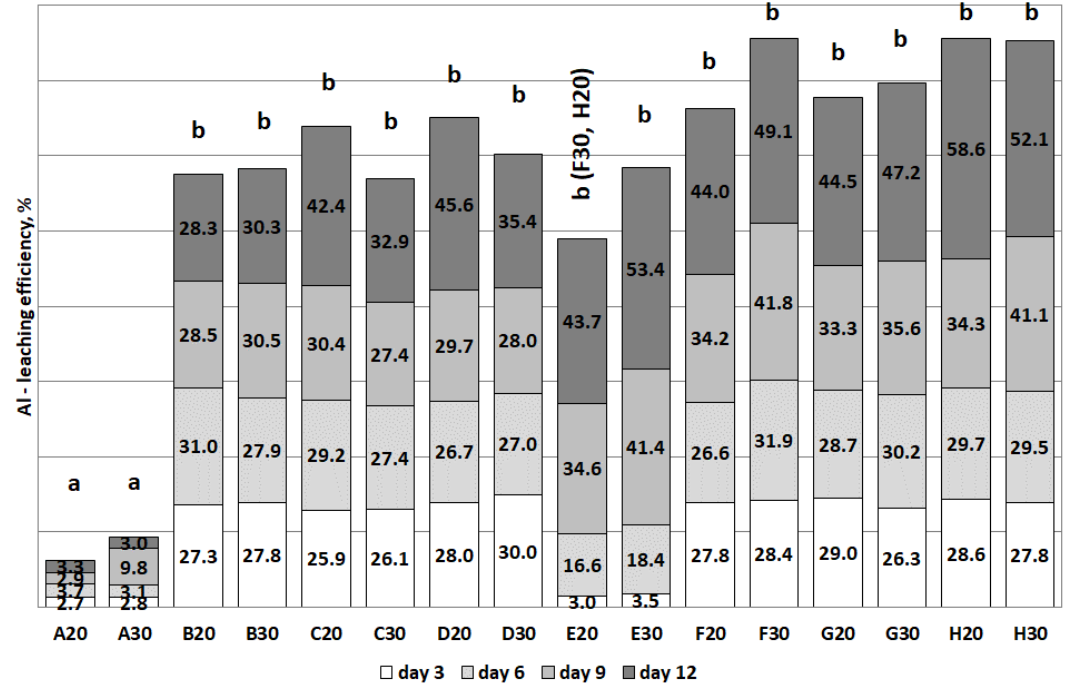
ffi ciency of Al during the experiment (Statistical groups a and Figure 6. Bioleaching efficiency of Al during the experiment (Statistical groups a and b ). Figure 6. Bioleaching e